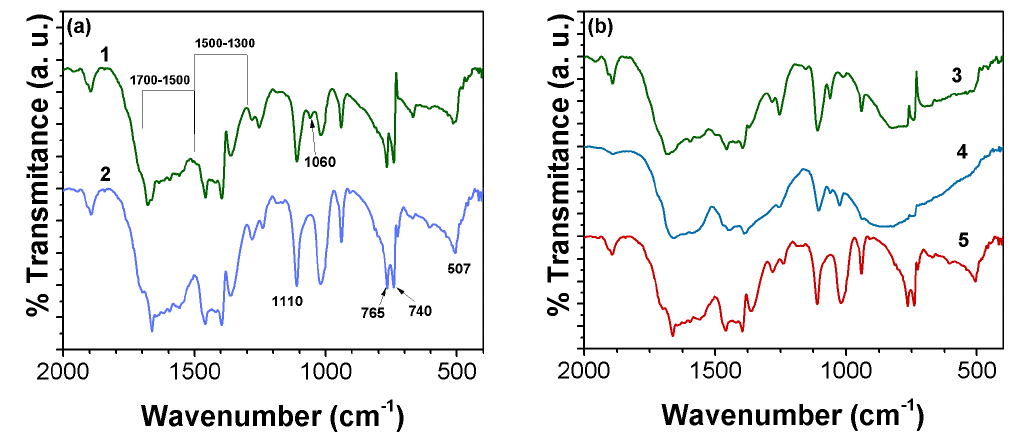
Figure 3. Fourier-transform infrared (FT-IR) spectra of ( a ) syn-HKUST-1 (1), com-HKUST-1 (2) ( b ) 50TiO 2 P25/syn-HKUST-1 (3), 50TiO 2 ST/com-HKUST-1 (4), and 50TiO 2 P25/com-HKUST-1 (5).